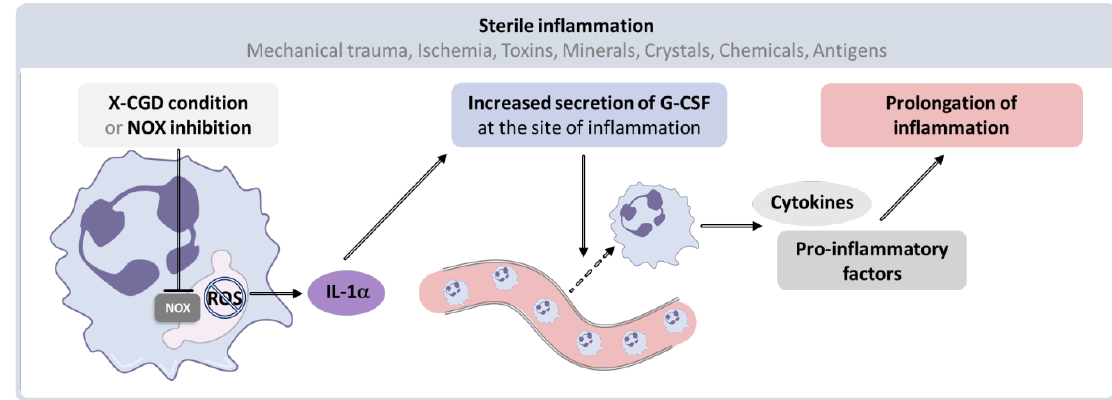
Figure 15. Mechanism of inflammation in the absence of NOX activation. Sterile inflammation can be triggered by physical, chemical, or metabolic noxious stimuli. In these conditions, the lack of phagocytic NOX activity leads to the overproduction of IL-1 α by tissue-resident macrophages, promoting the local production of G-CSF, which induces an excessive infiltration of neutrophils and monocytes at the inflammation site. This leads to increased production of cytokines and pro-inflammatory factors that prolong the inflammation, ultimately resulting in tissue damage. Inspired by